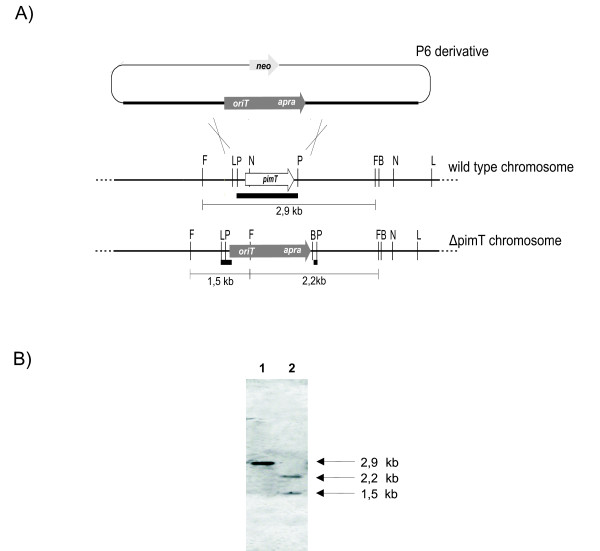
Gene replacement of pimT. A) Predicted restriction enzyme polymorphism caused by gene replacement. The AflIII restriction pattern before and after replacement is shown. The probe is indicated by thick lines. B, BamHI; F, AflIII; L, ApaLI; N, NruI; P, PvuI. B) Southern hybridization of the AflIII digested chromosomal DNA of the wild type (lane 1), and ΔpimT (lane 2) strains.